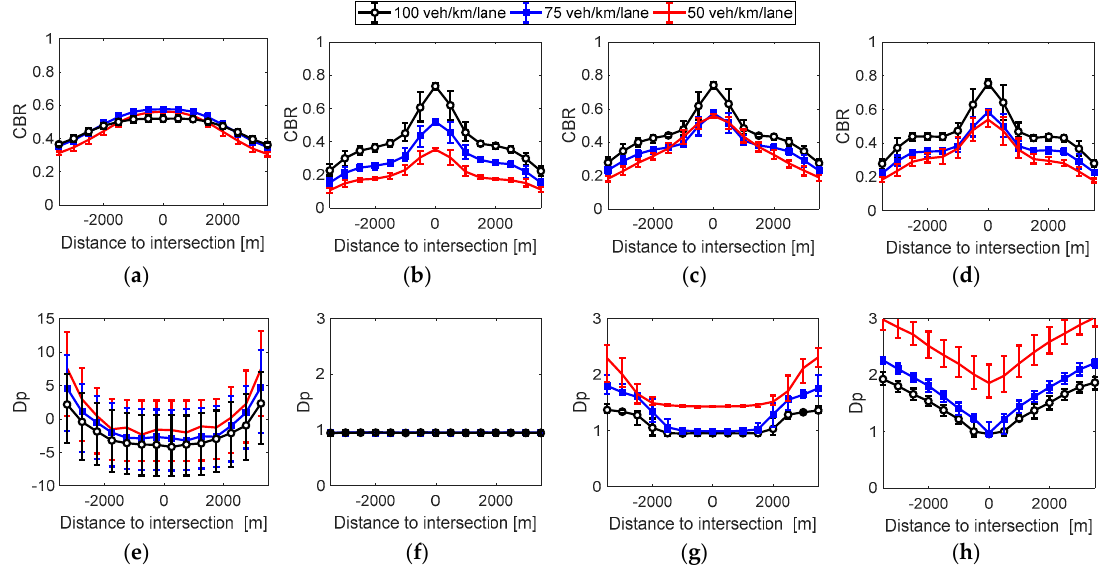
Figure 5. Average spatial distribution of the CBR and D p metric experienced with the different protocols analyzed. The vertical lines represent the 5th and 95th percentiles. The application requirements are satisfied if D p > 0. ( a ) A-DCC. ( b ) MINT. ( c ) INTERN. ( d ) COMPASS. ( e ) A-DCC. ( f ) MINT. ( g ) INTERN. ( h ) COMPASS.